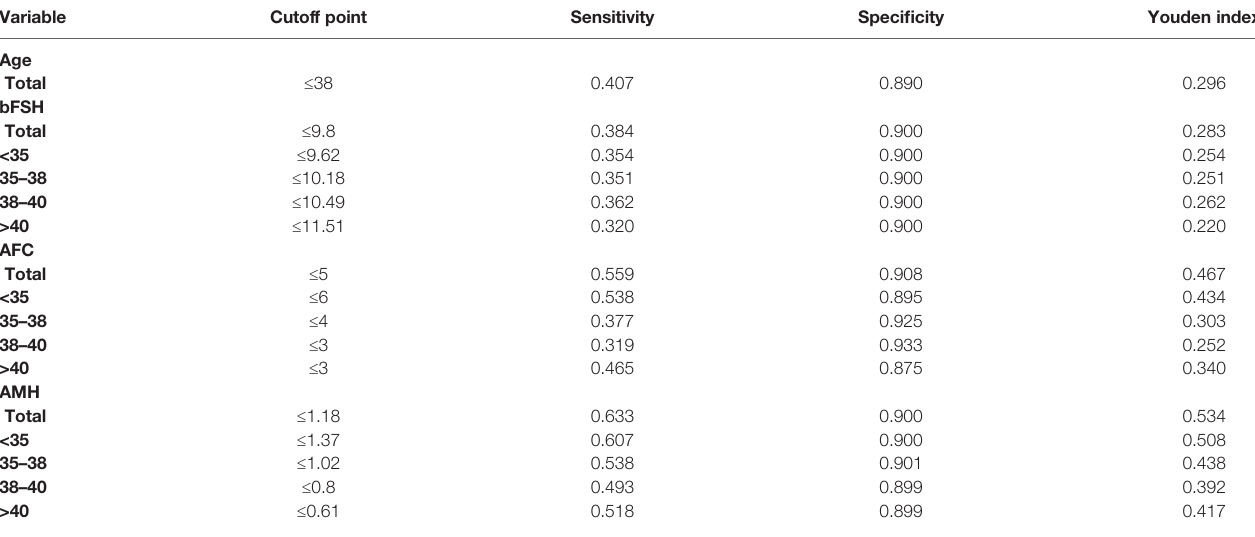
TABLE 4 | Cutoff point analysis — total group and age strati fi cation. Variable